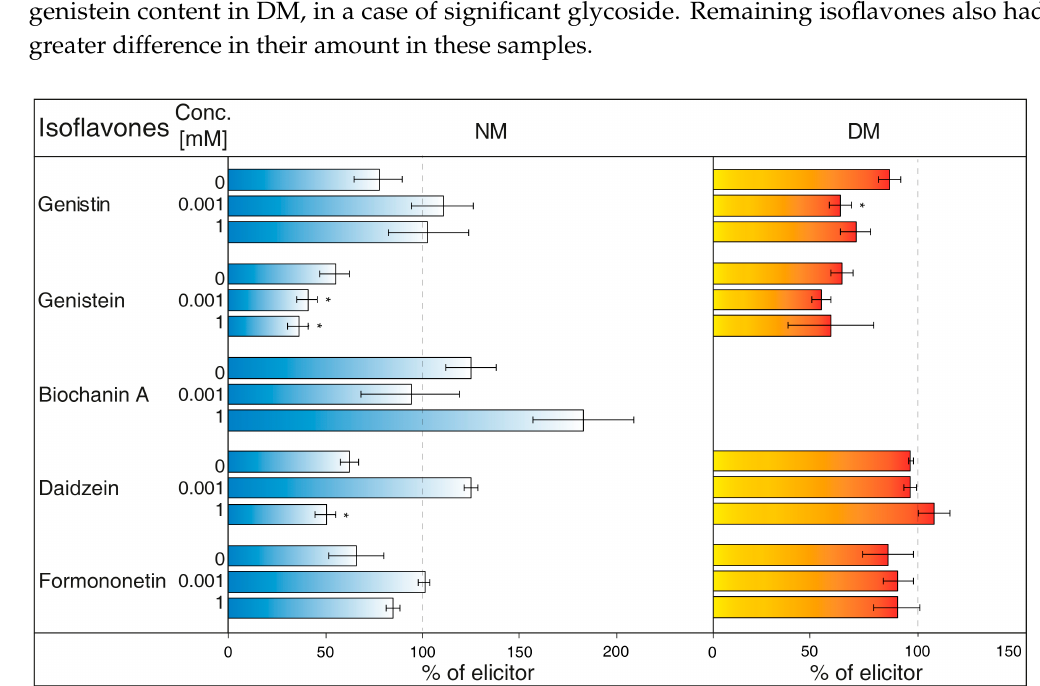
Figure 5. Effects of Na 3 VO 4 on isoflavone content in nutrient medium (NM) and dry matter (DM) of Genista tinctoria cell culture. Zero concentration of inhibitor represents water control. All bar values were recalculated to a relative 100% isoflavone content in samples with NH 4 VO 3 (1 µ M) after 24 h. Data are mean of three repeats ± SE; (*) represent significant difference ( p < 0.05) between elicited and inhibited or water control samples within Tukey’s